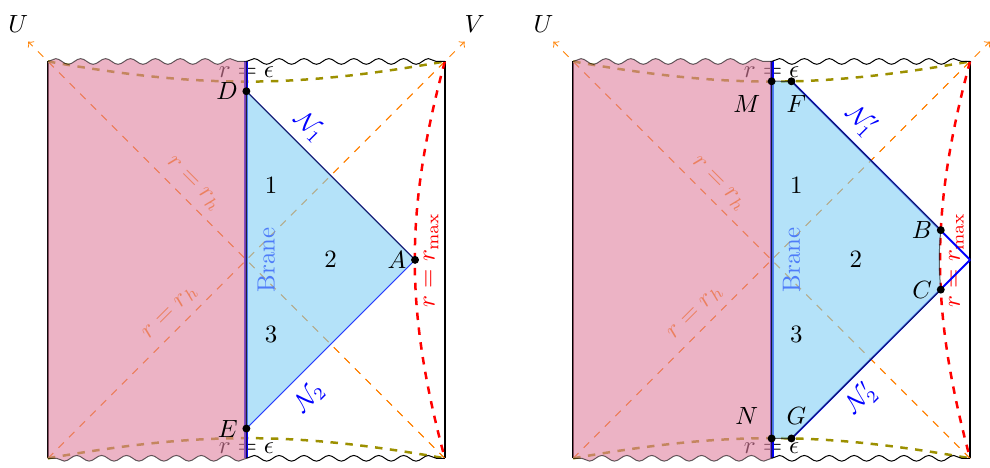
Figure 7 . WDW patch indicated by the cyan shaded region for T = 0 in the left) (cid:12)rst regularization and right) second